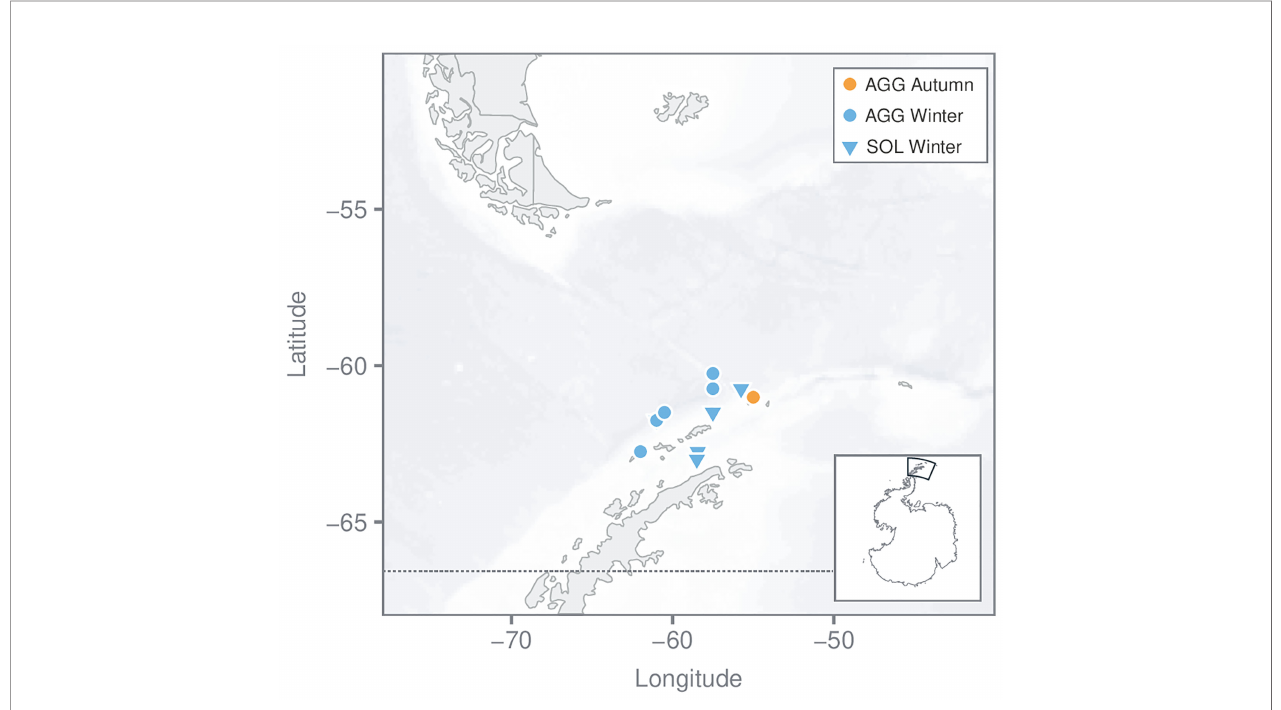
FIGURE 2 | Map of sampling stations in/near the Brans fi eld Strait. Salp samples [ Salpa thompsoni ; aggregates (AGG) and solitaries (SOL)] were collected in winter (August 2016) and in autumn (April 2018) using an Isaacs-Kidd midwater trawl. Different symbol colors indicate the different sampling seasons, whereas different symbol shapes indicate different